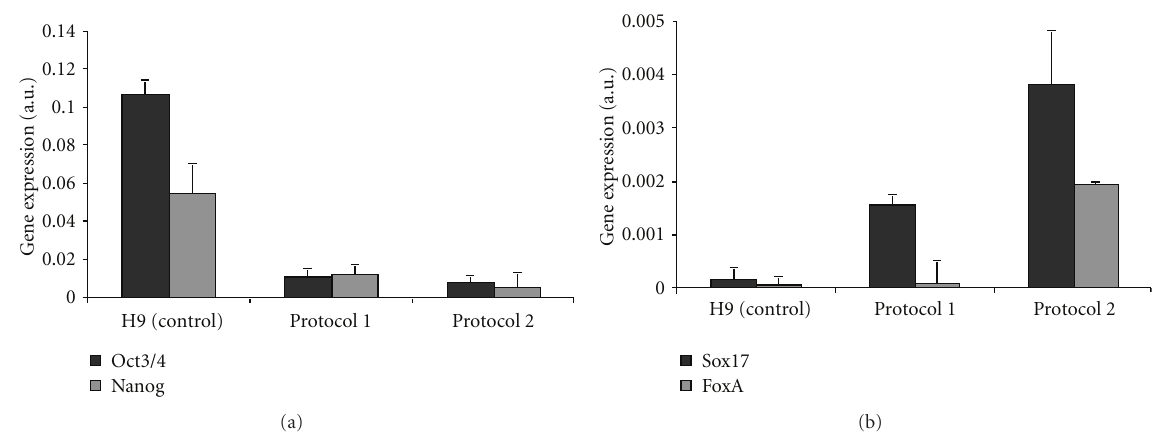
Figure 4: Expression of pluripotency (a) and definitive endoderm (b) mRNA markers at directed endoderm di ff erentiation. Human ESCs were di ff erentiated using two protocols described in Section 2. Detailed marker description is presented in Table 1.